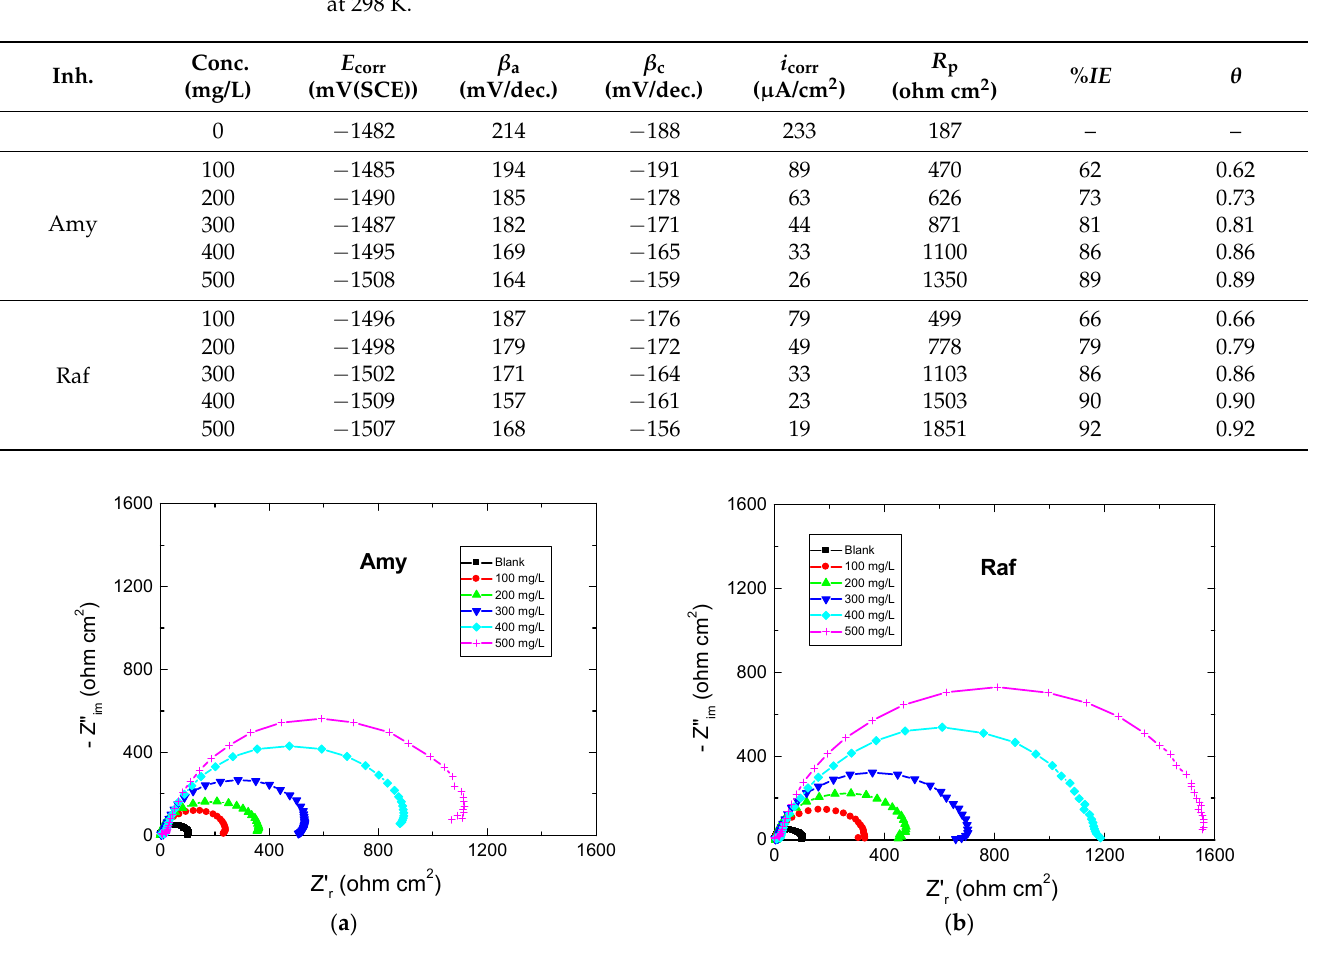
Table 2. Values of PDP parameters for Al corrosion in 0.1 M NaOH medium and with Amy and Raf at 298 K.